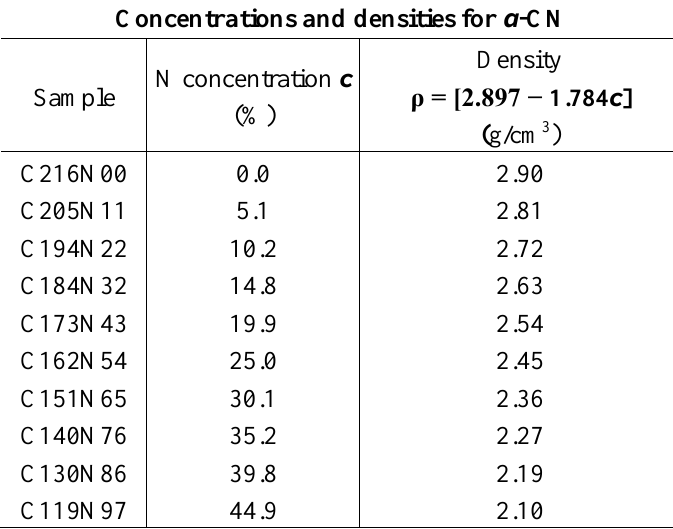
Table 4. Supercells of the amorphous alloy CN with the nitrogen concentrations and their